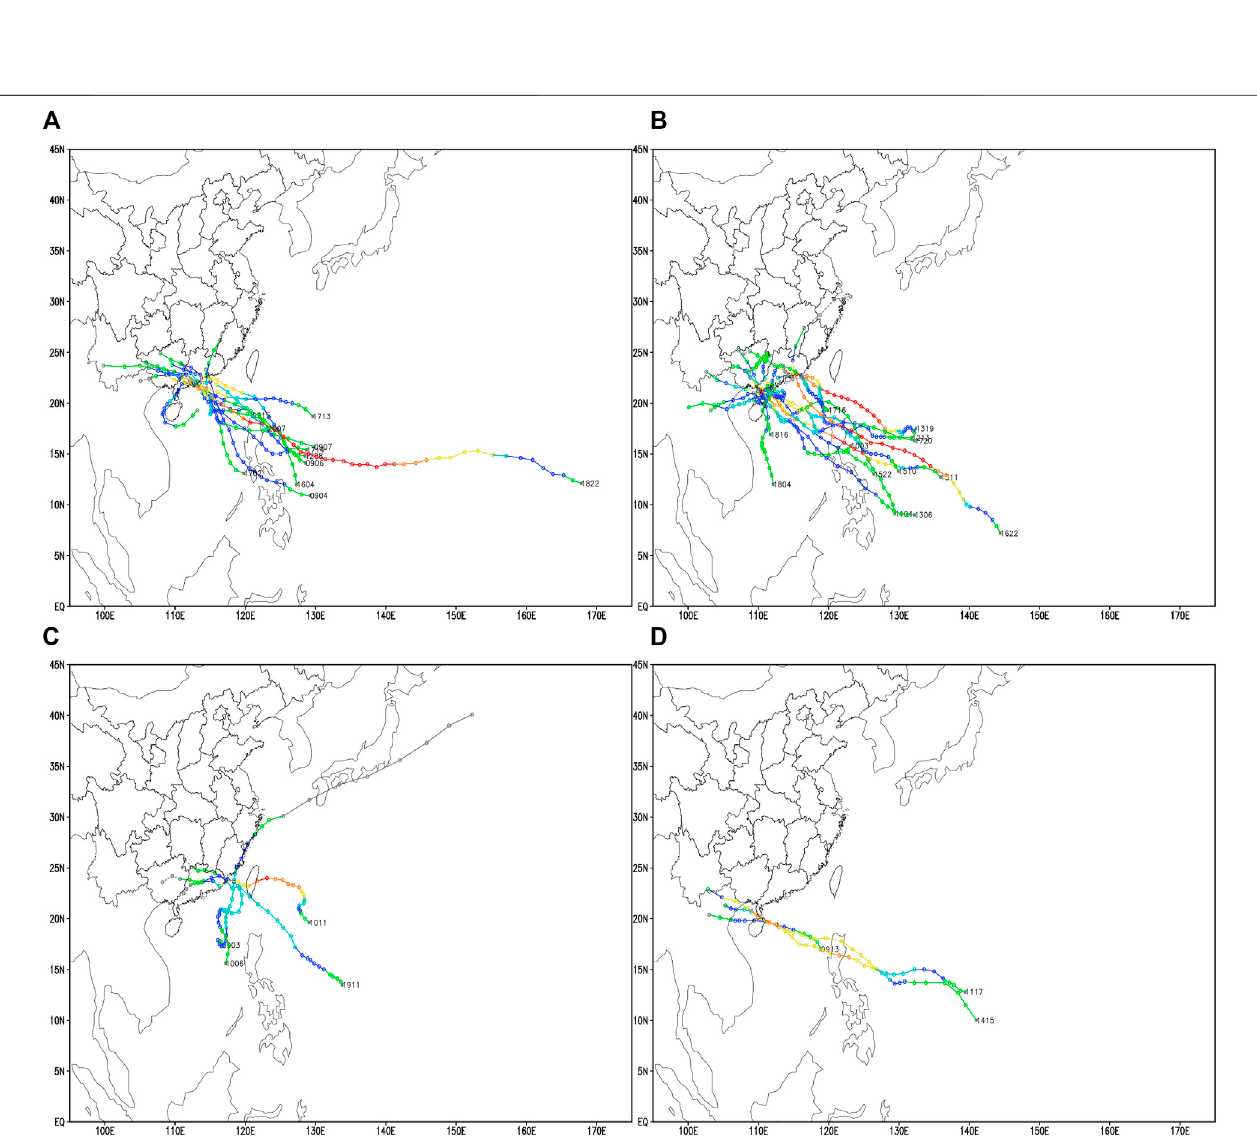
FIGURE3| Tracks ofdisaster-causingtyphoonsinGBA (A) landfallinGBA; (B) landfallinother places ofGuangdong; (C) landfall inTaiwan orFujian; (D) landfall in Hainan. The colors represent different typhoon levels. Gray means below the intensity of tropical depression, green means tropical depression, blue means tropical storm,cyanmeansseveretropicalstorm,yellowmeanstyphoon,orangemeansstrongtyphoon,andredmeanssupertyphoon.Thenumberindicatesthetyphoonserial number.